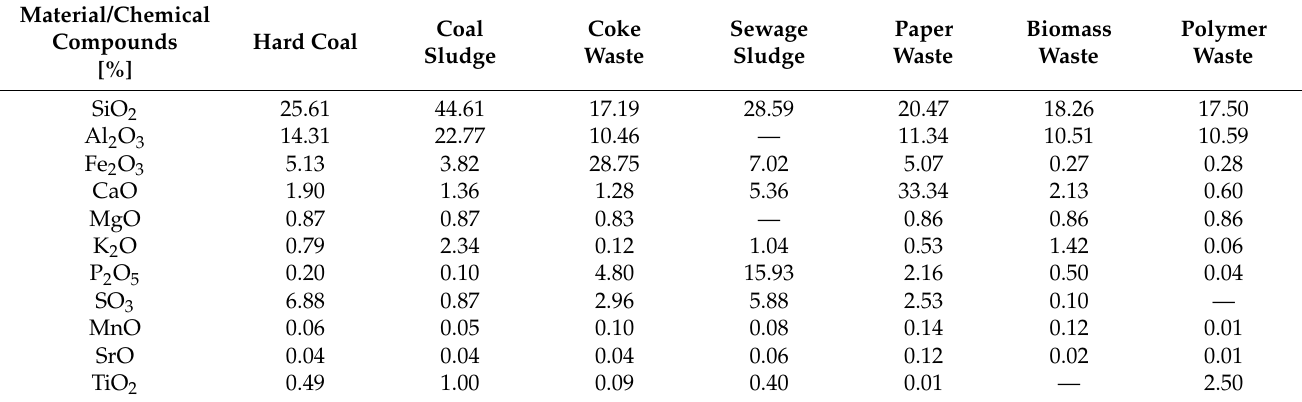
Table 3. The chemical analysis of XRF of materials’